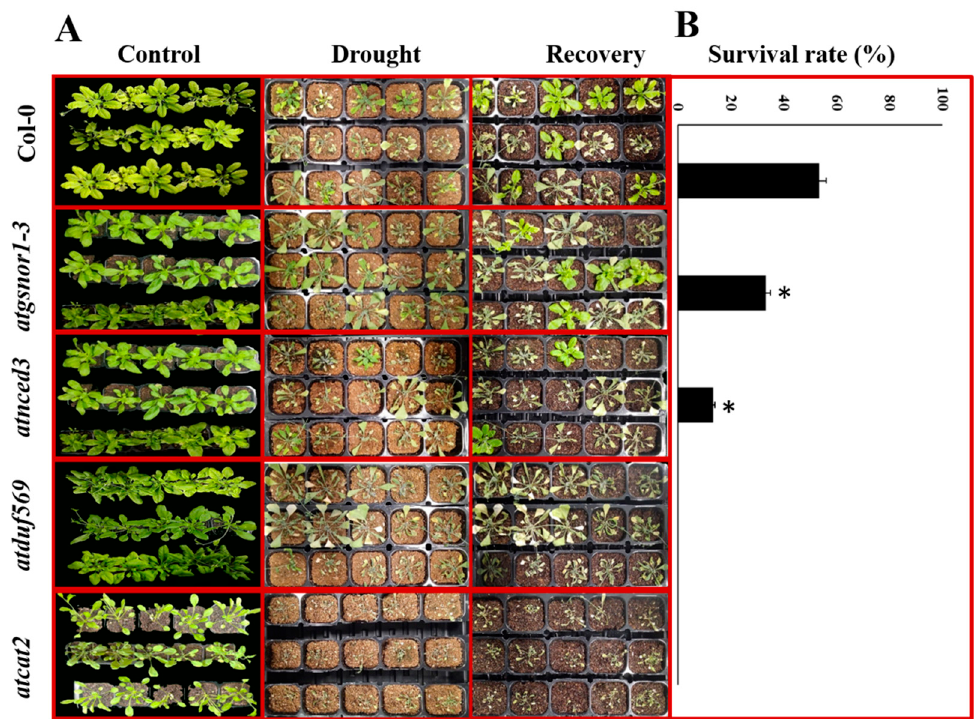
Figure 2. The phenotypes of Arabidopsis plants (WT Col-0, atgsnor1-3 , atnced3 , atduf569 , and atcat2 ) in normal, drought, and recovery conditions. ( A ) Starting top to bottom with the left side (control) are Col-0 (WT), atgsnor1-3 (drought tolerant mutant), atduf569 (KO mutant), atnced3 (drought-sensitive mutant), atcat2 (oxidative stress-responsive mutant). Next, the second (middle) part designated plants exposed to drought stress. The third (right) side part exhibiting plants of the designated genotypes after recovery from water withholding. ( B ) The survival rate after drought stress was initiated by withholding water and then rewatering (for 24 h after). Data represent means of values obtained from experiments performed in triplicate. Error bars represent standard deviation. Means were analyzed for significant differences using Student’s t -test. Asterisks * indicate significant differences at 5% level of significance (* p < 0.05).